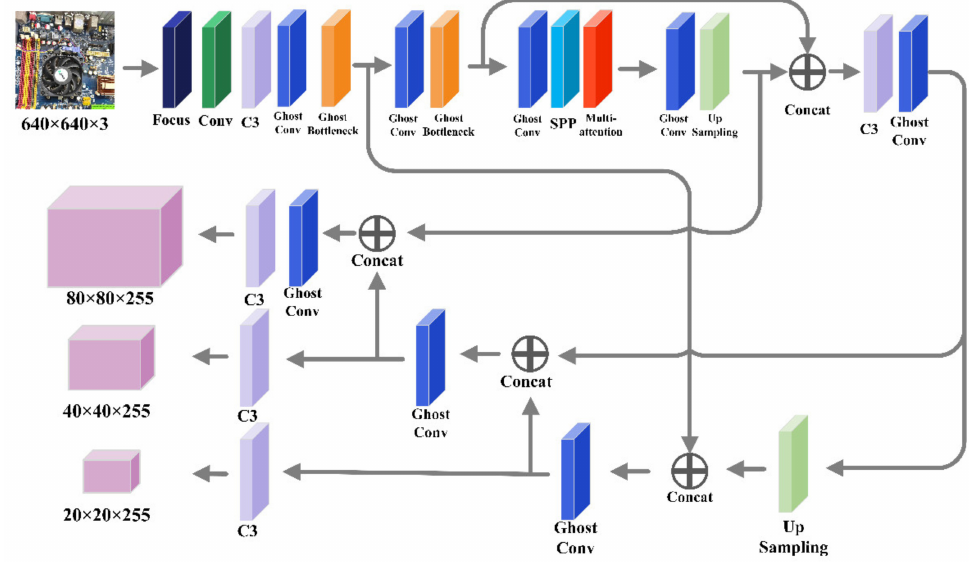
Figure 2. QD-YOLO network